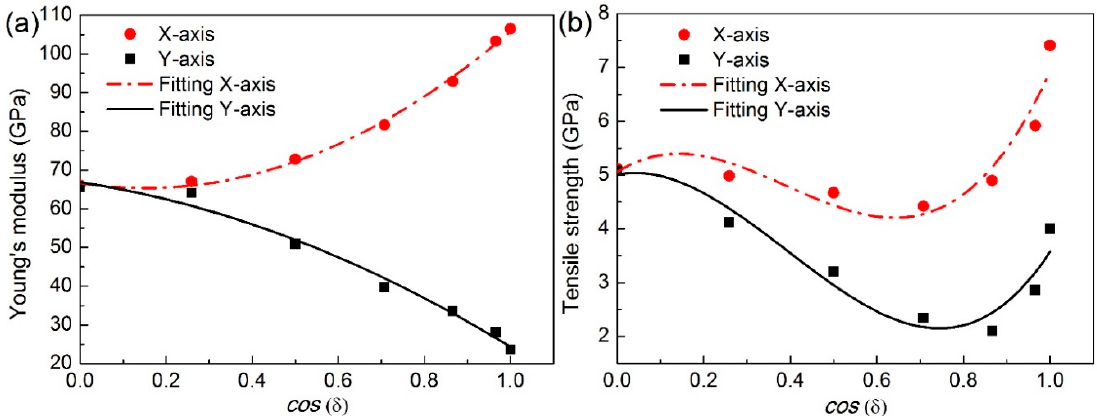
Figure 4. The effect of stacking angle difference δ on ( a ) Young’s modulus, and ( b ) tensile strength of the angle-ply DLBP during the tension process along both X- and Y-axes.